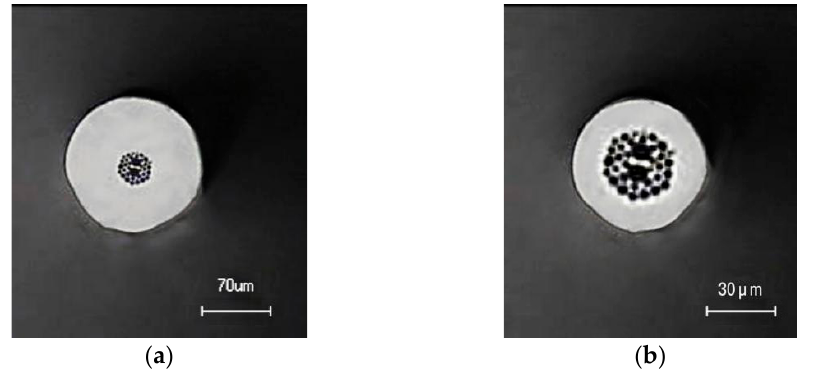
Figure 2. ( a ) The cross-section of the MSF; ( b ) the cross-section of the MSF after corrosion treat- ment.